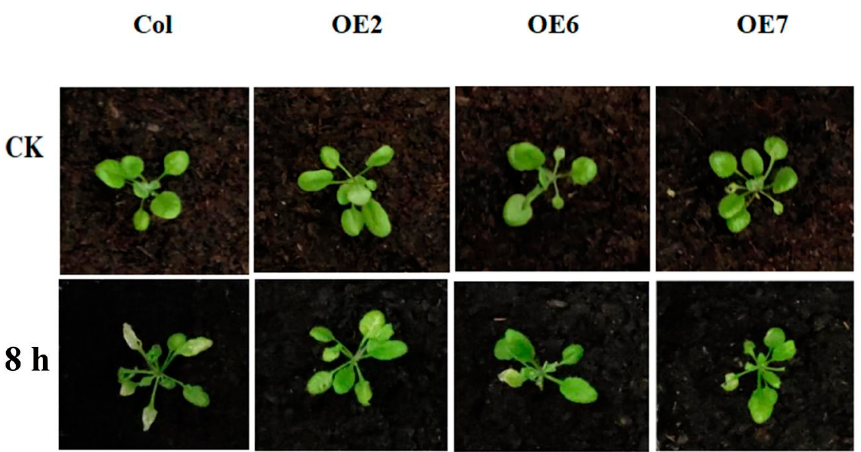
Figure 10. Heat tolerance analysis of transgenic Arabidopsis lines. The phenotypes of the WT and transgenic Arabidopsis seedling lines 2, 6 and 7 are shown following their treatment with different heat stress. CK (0 h), the control condition and Heat (8 h), the heat stress conditions. The 3-week-old seedlings were directly exposed to 42 °C to detect heat tolerance in 0 h and 8 h. The Arabidopsis were photographed in 3 d after the 0 h and 8 h heat stress treatment. The wilting degree of leaves of both the WT and transgenic lines was observed at 3 days after the 8 h heat stress treatment. Furthermore, to explore molecular mechanism of heat tolerance of transgenic Arabidopsis in response to heat stress, we compared the proline contents of WT and transgenic Arabidopsis lines under 42 °C treatment at 0 h and 8 h. The proline contents of these 4 Arabidopsis lines exposed to heat stress treatment have been displayed to increase